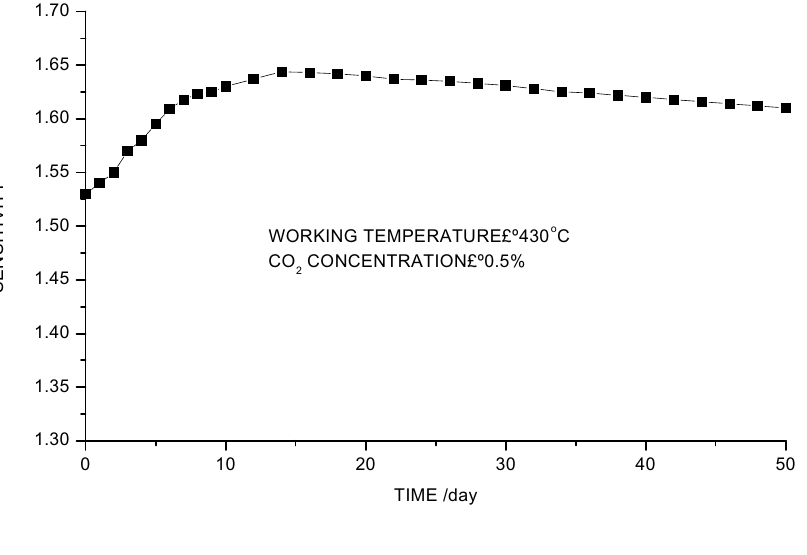
Figure 8. Stability of CuO-BaTiO